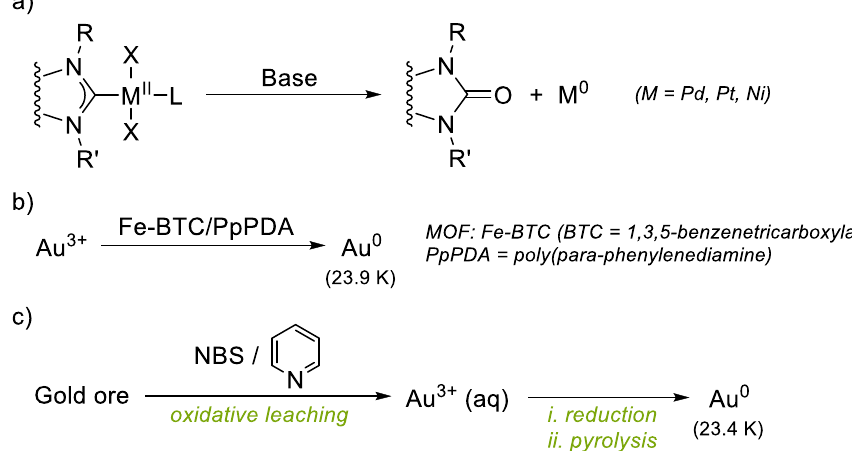
Figure 1. ( a ) Examples of azolone decomposition pathways of NHC-M, and ( b , c ) strategies to recover highly pure Au(0) (>23 karats).